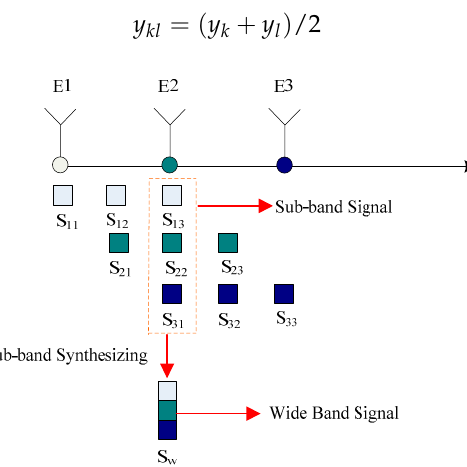
Figure 3. The equivalent phase center of the 3-channel range MIMO SAR.